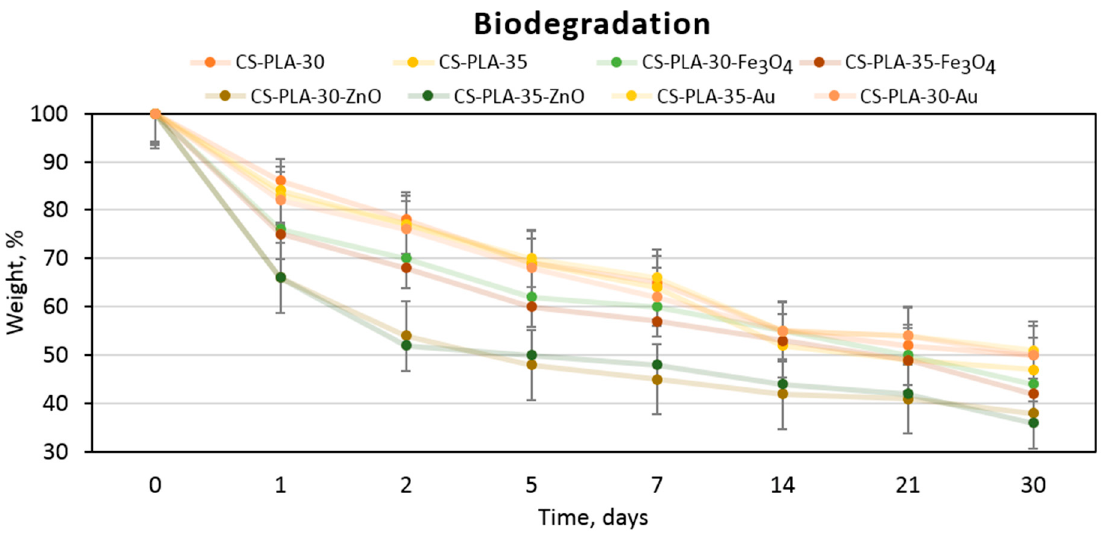
Figure 9. Biodegradability of the prepared scaffolds.